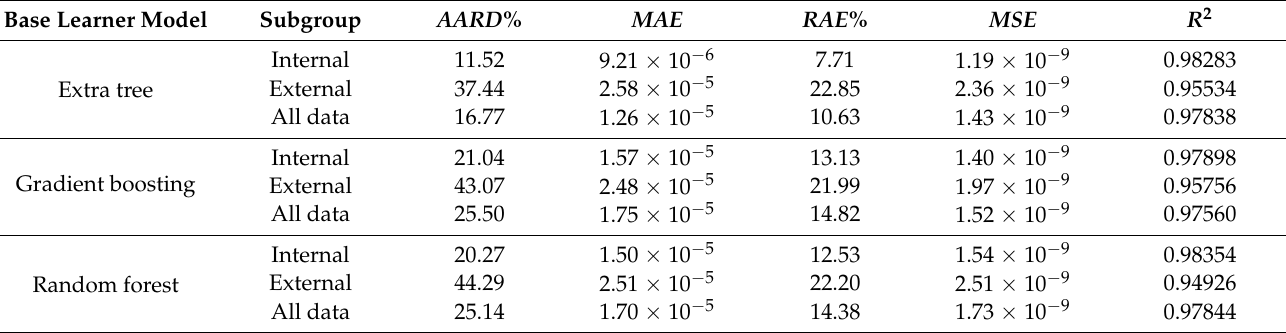
Table 3. Prediction accuracy of the base leaner machines.